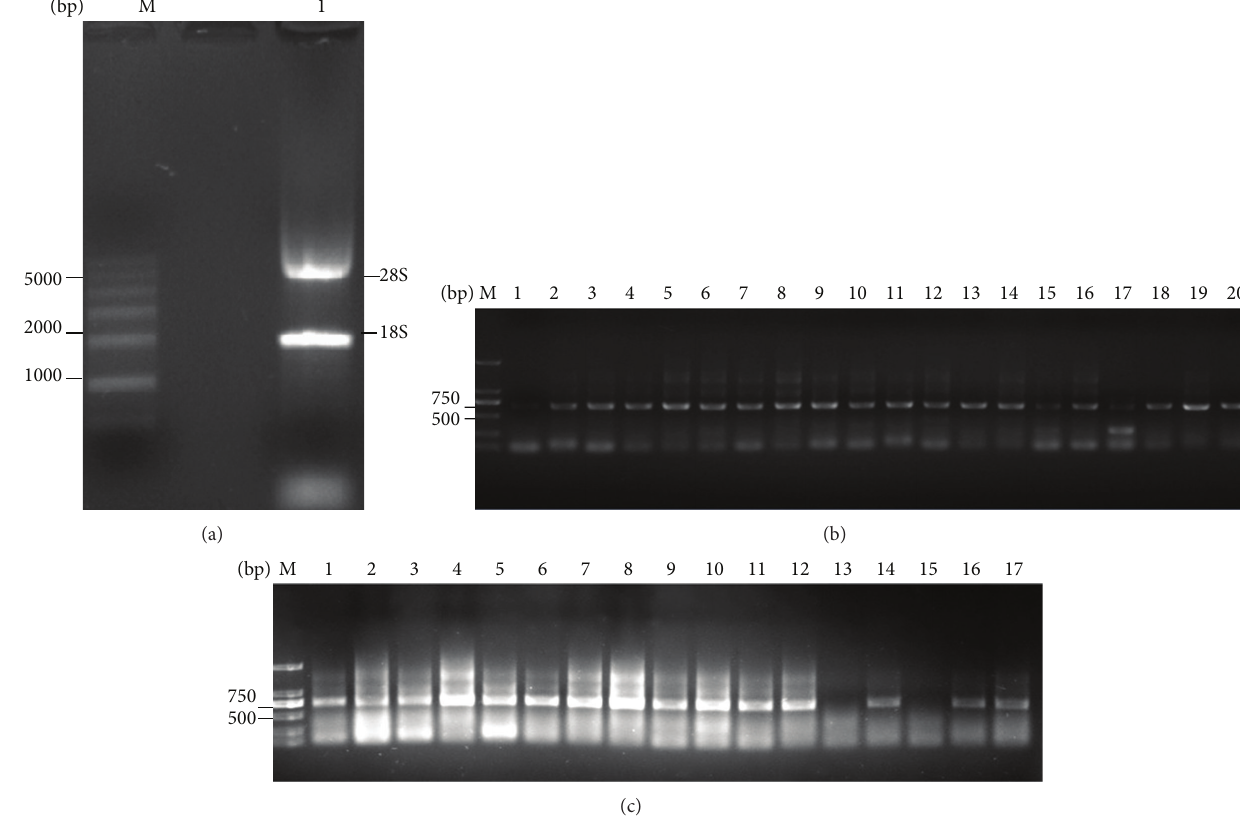
Figure 1: Agarose gel electrophoresis of total RNA and the PCR products of IgG light chains. (a) M: RL6000 RNA marker; lane 1: total RNA of mouse spleen; (b) PCR products of the 𝜅 chains (lanes 1 ∼ 18), PCR products of 𝜆 chains (lanes 19 ∼ 20); (c) PCR products of the Fd chains (lanes 1 ∼